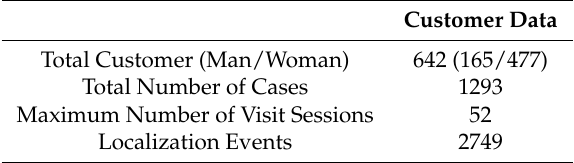
Table 4. Summary of the corpus after combining into shop